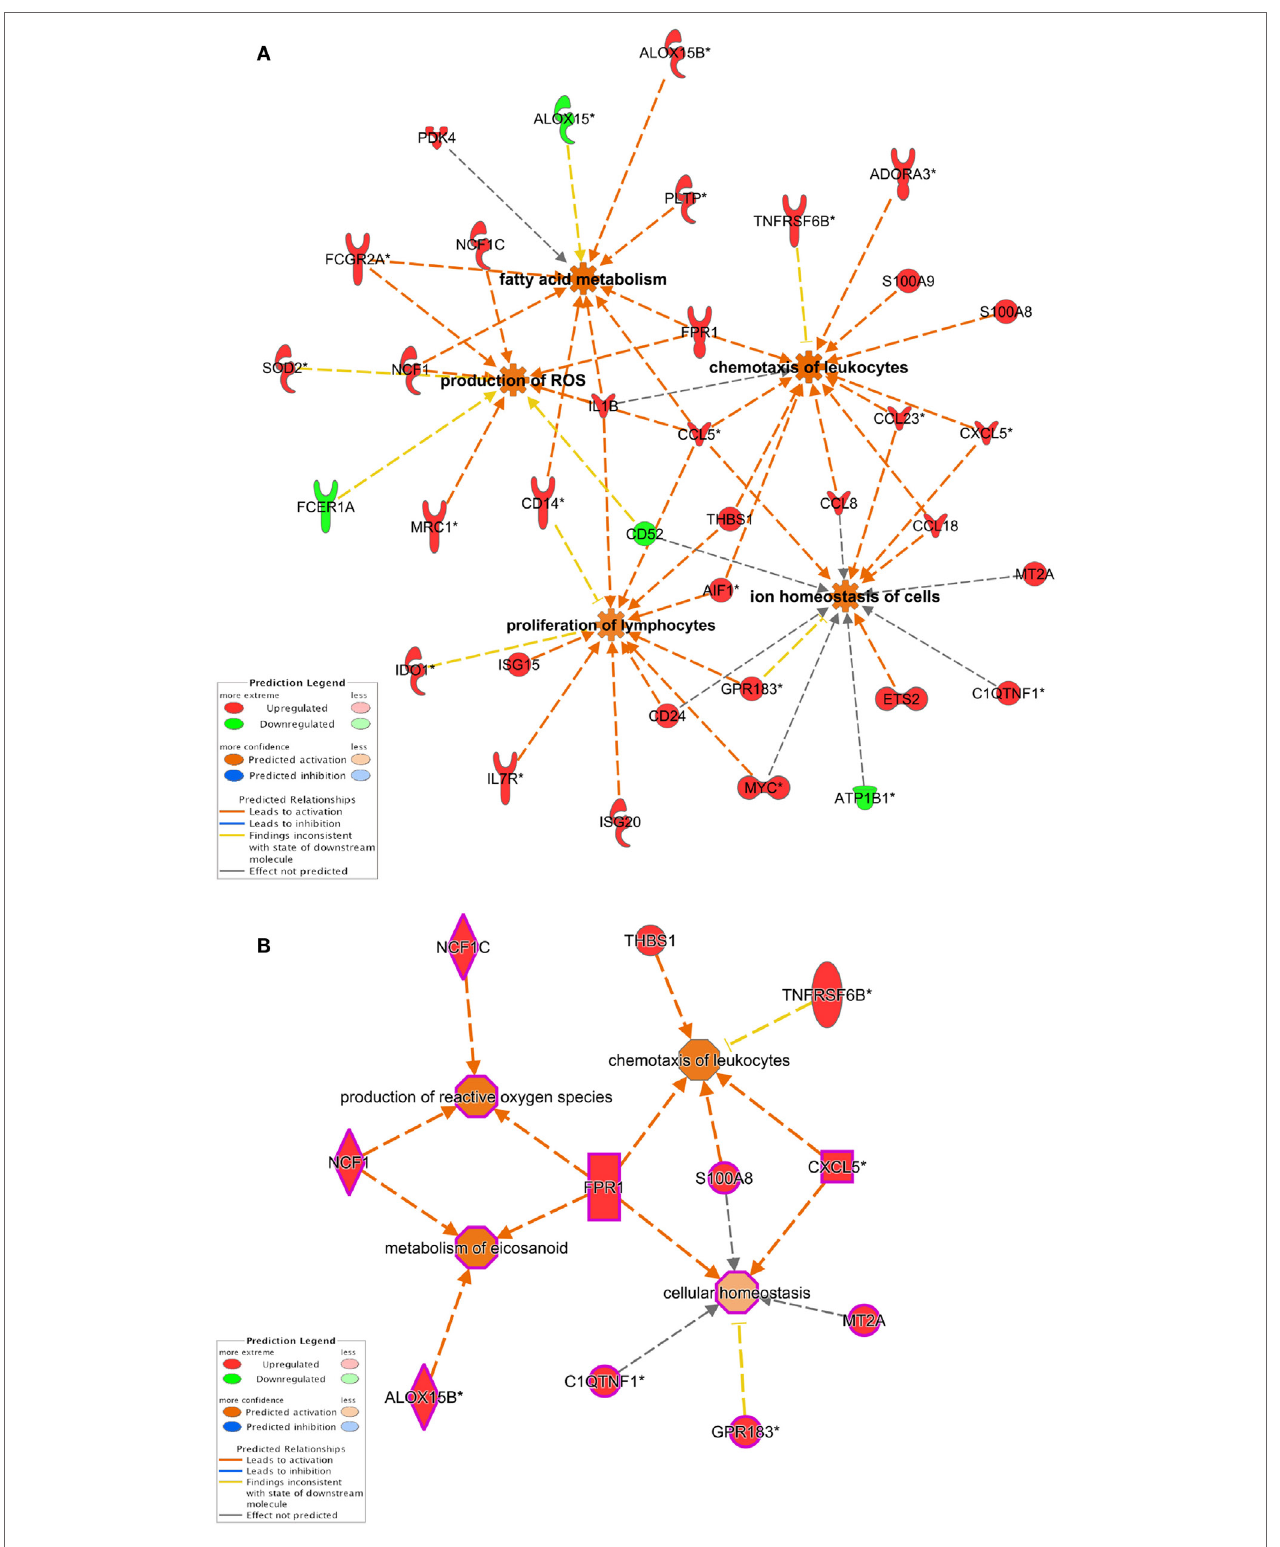
FigUre 4 | Dexamethasone (Dex) and monphosphoryl lipid A (MPLA) treatment leads to changes in the expression of genes involved in biological processes associated with immune response regulation. (a) Ingenuity pathway analysis network interaction analysis of differentially expressed genes in Dex-modulated and MPLA-activated dendritic cells shows that genes modulated by Dex and MPLA are involved in the control of T-cell activation, cell movement, and metabolism. (B) Network interaction analysis of genes from Cluster 6 (see Figure 3 ), modulated synergically by dexamethasone and MPLA.